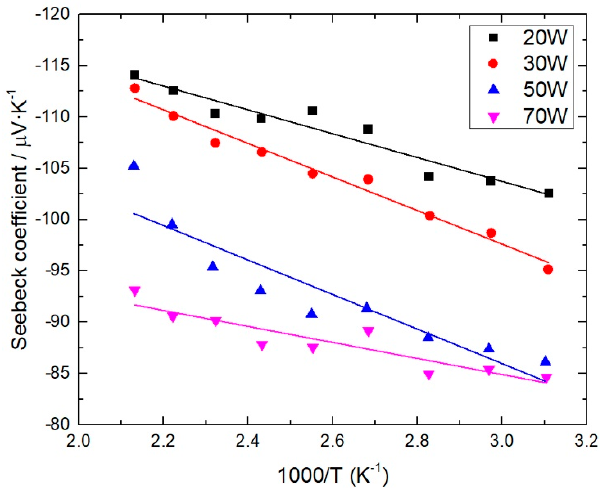
Figure 8. Curve fittings of the Seebeck coefficients of the Bi 2 Te 3 films